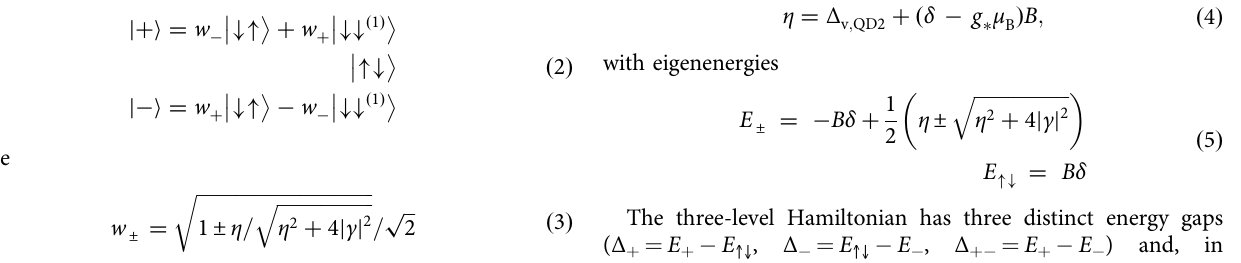
, as a function of QD-QD 2 ) as a function of QD-QD detuning. 2